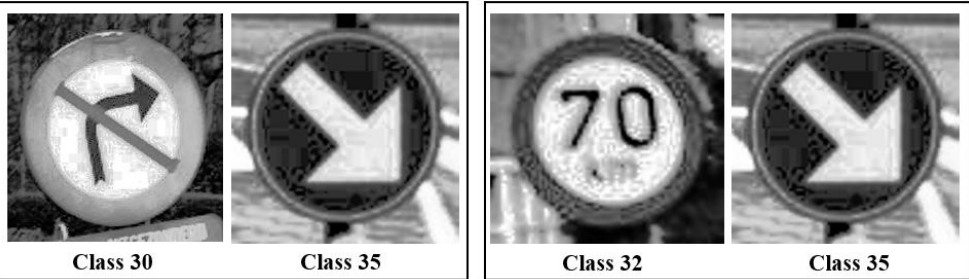
Figure 10. Misclassified classes of 30 and 35 ( left ) and 32 and 35 ( right